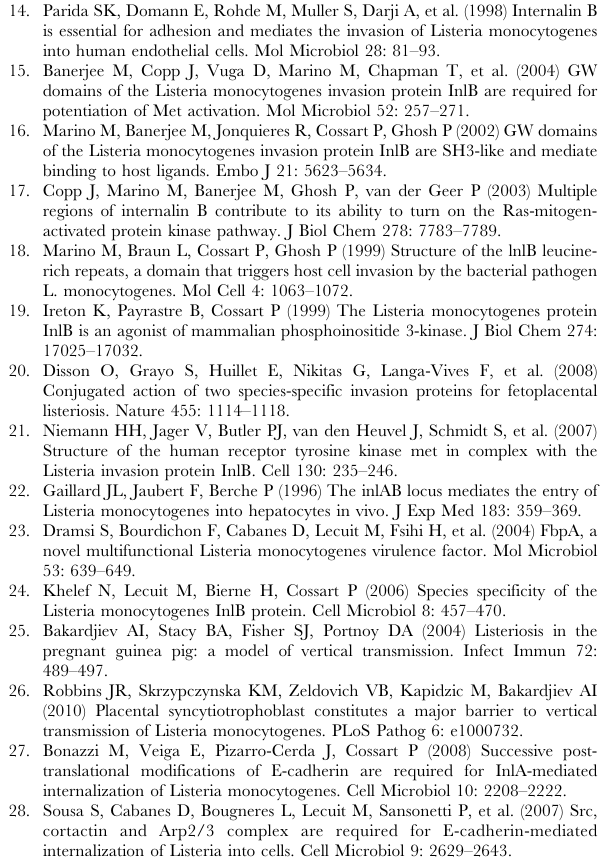
MDCK monolayers. Insets show multicellular junctions